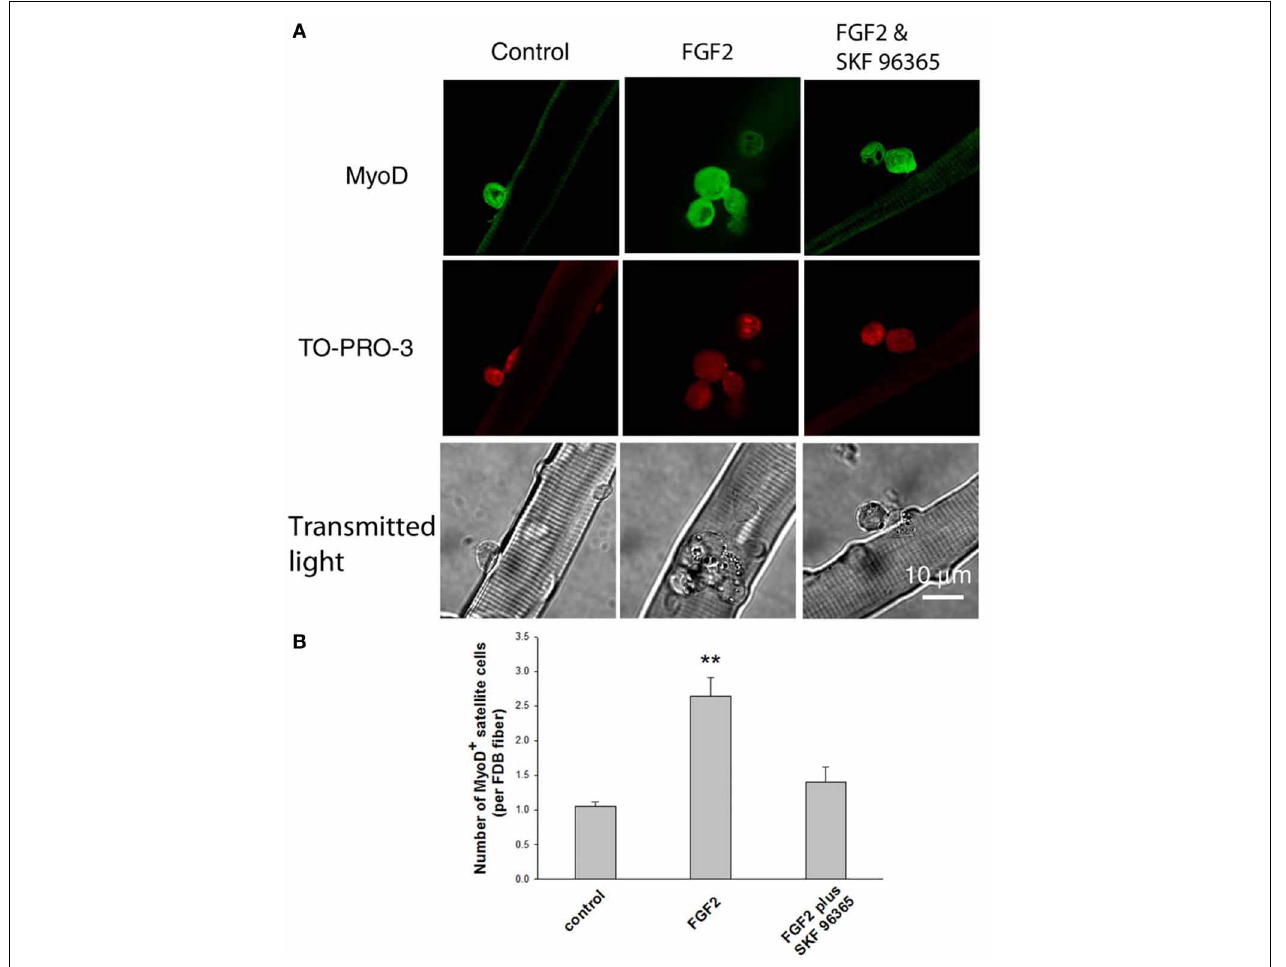
FIGURE 5 | Effects of FGF2 on satellite cell activation and proliferation. Freshly isolated FDB fibers associated with satellite cells were cultured for 24h without FGF2, with FGF2, or with both SKF 96365 and FGF2. FGF2 significantly increased the number of MyoD + cells associated with FDB fibers (middle column in A,B ). In cultures